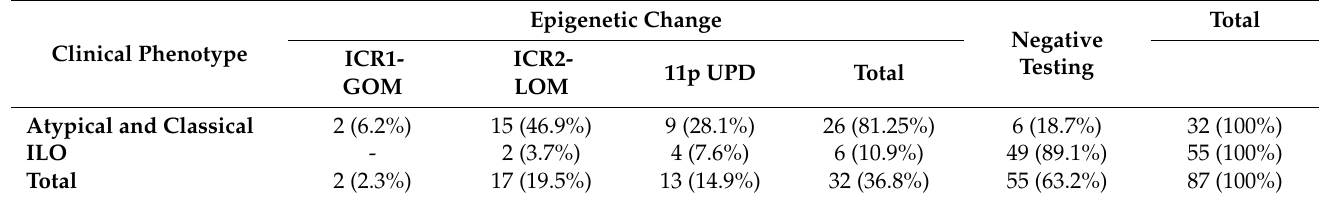
Table 2. Epigenetic alterations in the patients with lateralized overgrowth according to clinical phenotype.